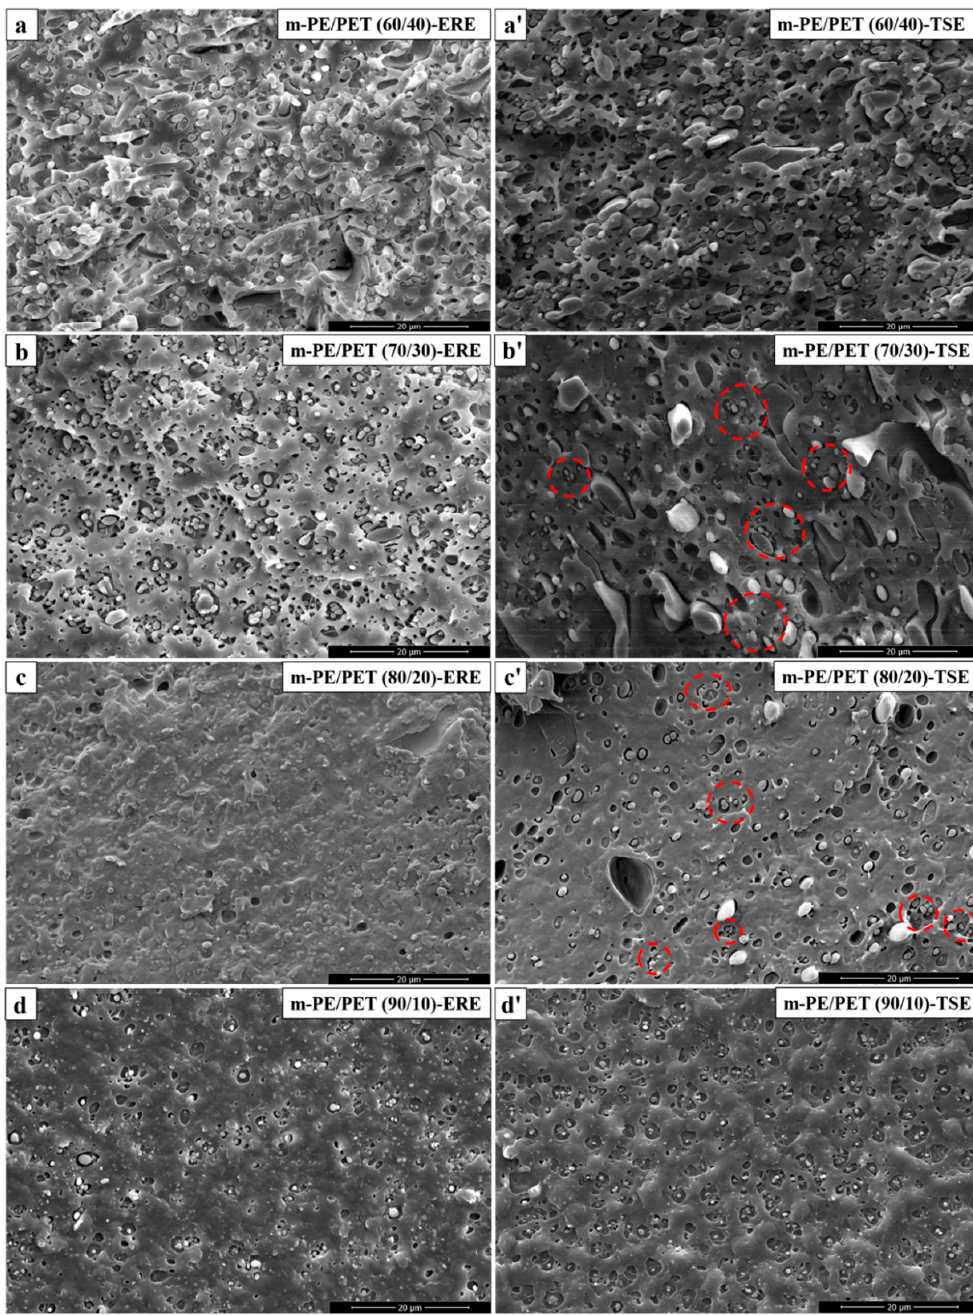
Figure 2. Scanning electron microscope (SEM) micrographs of the fabricated m-PE/PET blends Figure2. Scanningelectronmicroscope(SEM)micrographsofthefabricatedm-PE / PETblendsprocessed processed using ERE and TSE, respectively. ERE processed blends: ( a ) m-PE/PET 60/40; ( b ) m-PE/PET using ERE and TSE, respectively. ERE processed blends: ( a ) m-PE / PET 60 / 40; ( b ) m-PE / PET 70 / 30; 70/30; ( c ) m-PE/PET 80/20; ( d ) m-PE/PET 90/10. TSE processed blends: ( a’ ) m-PE/PET 60/40; ( b’ ) m- ( c ) m-PE / PET 80 / 20; ( d ) m-PE / PET 90 / 10. TSE processed blends: ( a’ ) m-PE / PET 60 / 40; ( b’ ) m-PE / PET PE/PET 70/30; ( c’ ) m-PE/PET 80/20; ( d’ ) m-PE/PET 90/10. 70 / 30; ( c’ ) m-PE / PET 80 / 20; ( d’ ) m-PE / PET 90 /